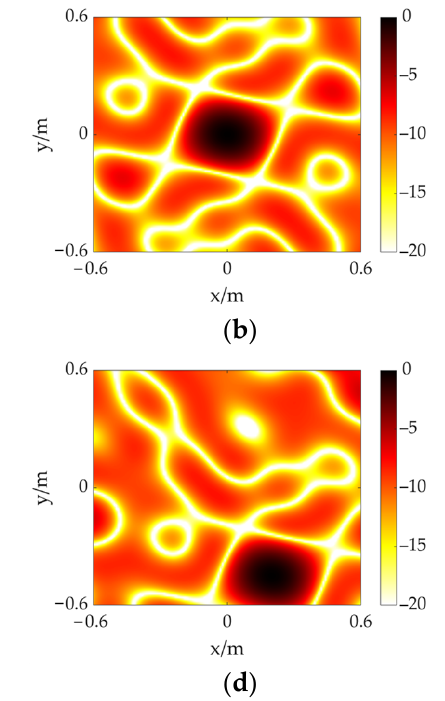
Figure 6. The simulation results of a single acoustic source at different positions including (0, 0)